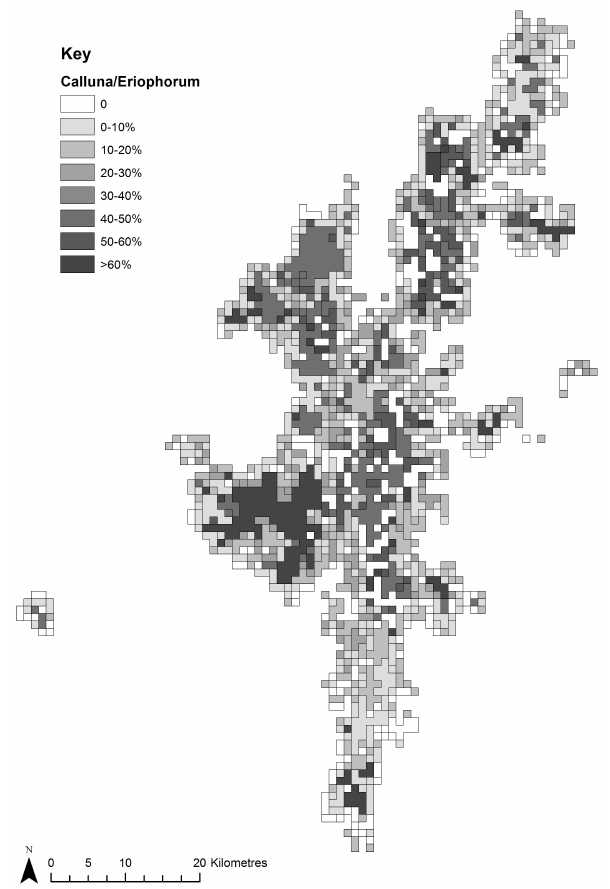
Figure 7. Estimated distribution of the Calluna/Eriophorum